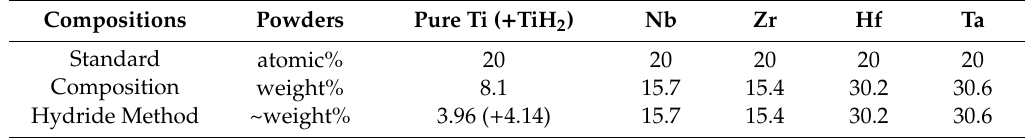
Table 2. Various compositions of initial powder mixtures.